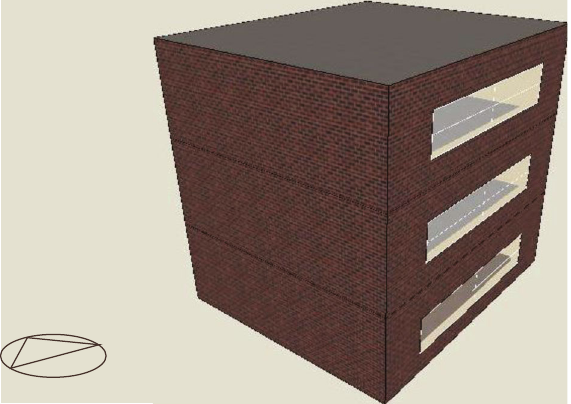
Figure 13: A sample simulated house for a building